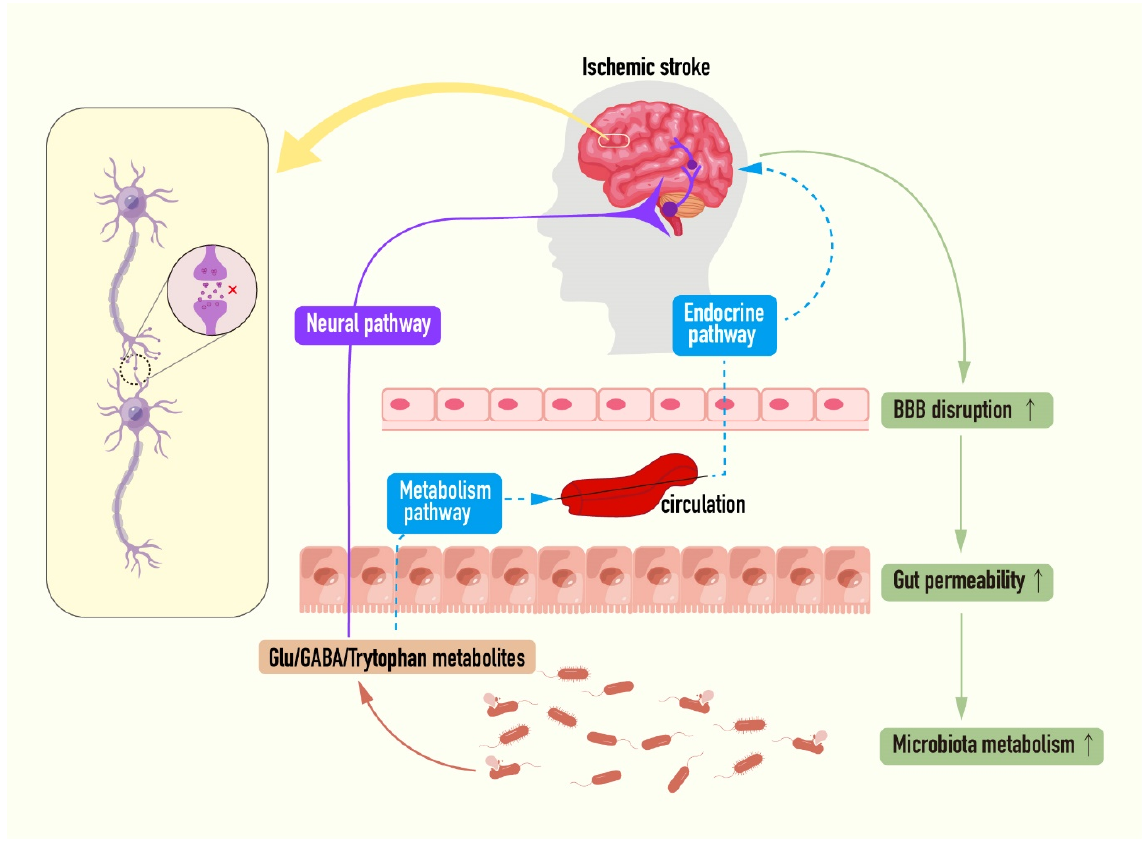
Figure 4. The interactions among the gut microbiota, ischemic stroke, and synaptic transmission. Stroke activates endogenous signal transduction through pro-inflammatory cytokine cascades to destroy intestinal flora to produce specific metabolites. While microorganisms can independently or promote the production of neuroactive molecules including glutamate, γ-aminobutyric acid, and tryptophan metabolites, then reaching the brain through the vagus nerve, spinal cord, or blood aggravate synaptic transmission disorder and brain injury. Furthermore, fecal microbiota transplantation, probiotics, and tryptophane may control the development of stroke by restoring intestinal homeostasis (the red cross indicates the synaptic transmission disorder; the vertical arrow in the rectangular frame indicates the up-regulation of corresponding pathological process)